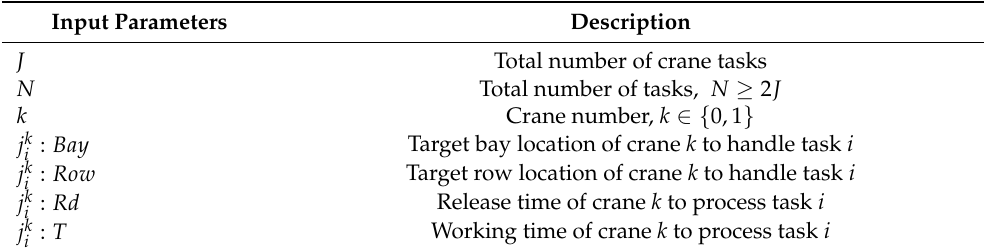
Table 3. Descriptions of input